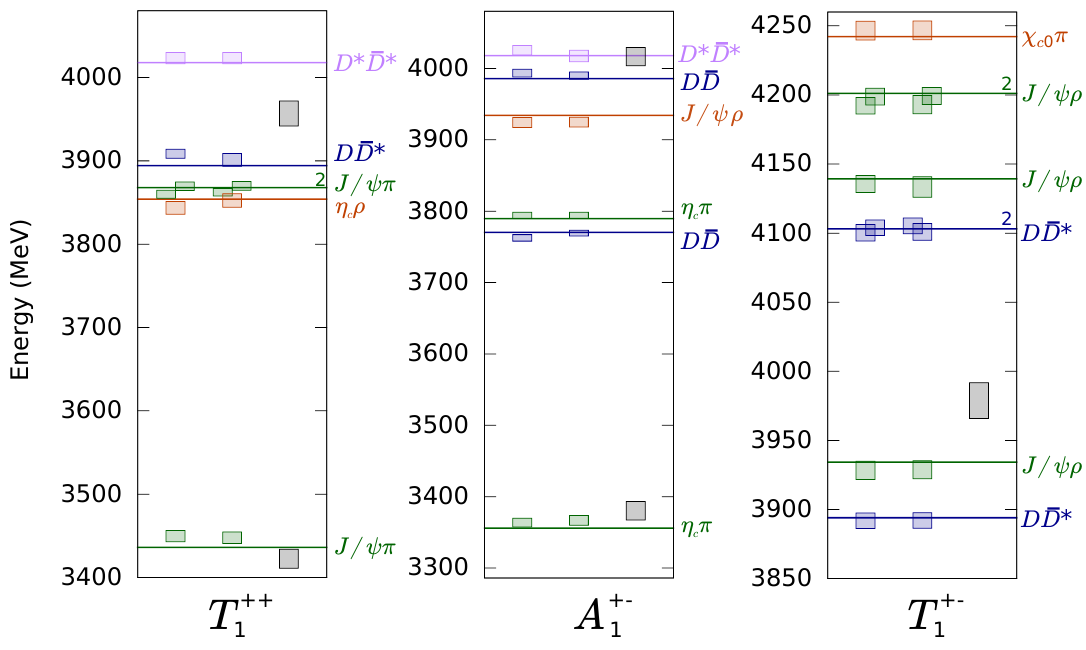
Figure 5 . As in the spectrum plot of (cid:12)gure 4 but showing the spectra for the isospin-1 hidden- charm sector with (cid:3) PG = T ++ ; A + (cid:0) ; T + (cid:0) . Within each plot, the left, middle and right column 1 1 1 shows the spectrum determined using the full basis of meson-meson and tetraquark operators, only meson-meson operators and only tetraquark operators